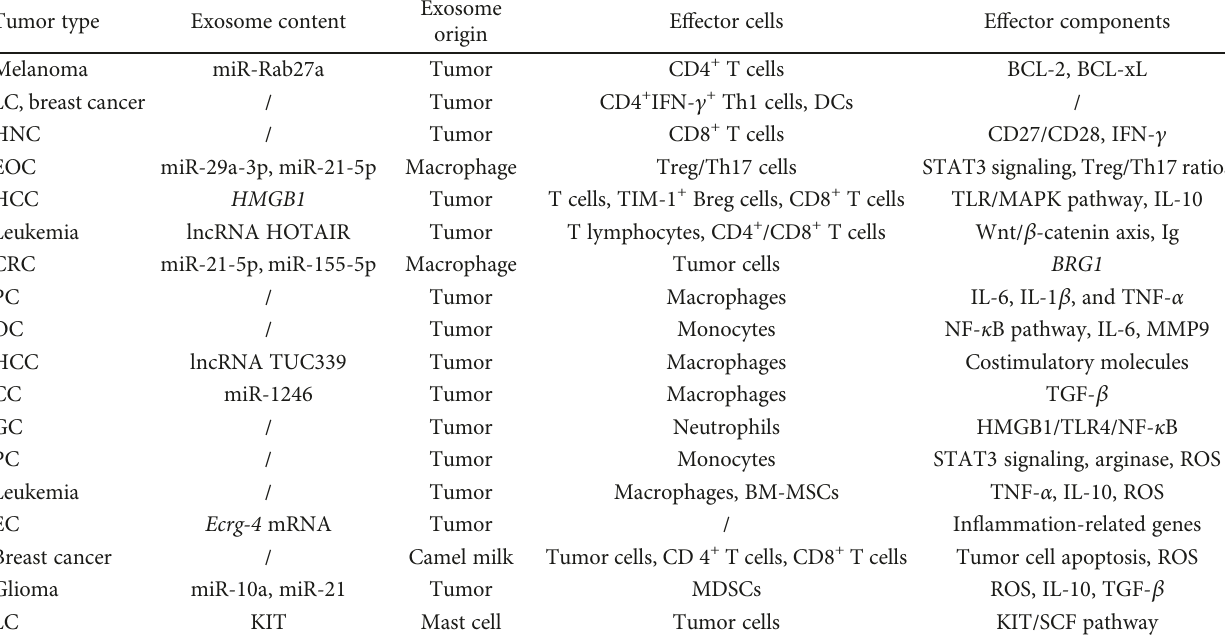
Table 1: Exosome functions in the tumor microenvironment: e ff ects on the tumor, immunity, and in fl ammation. Tumor